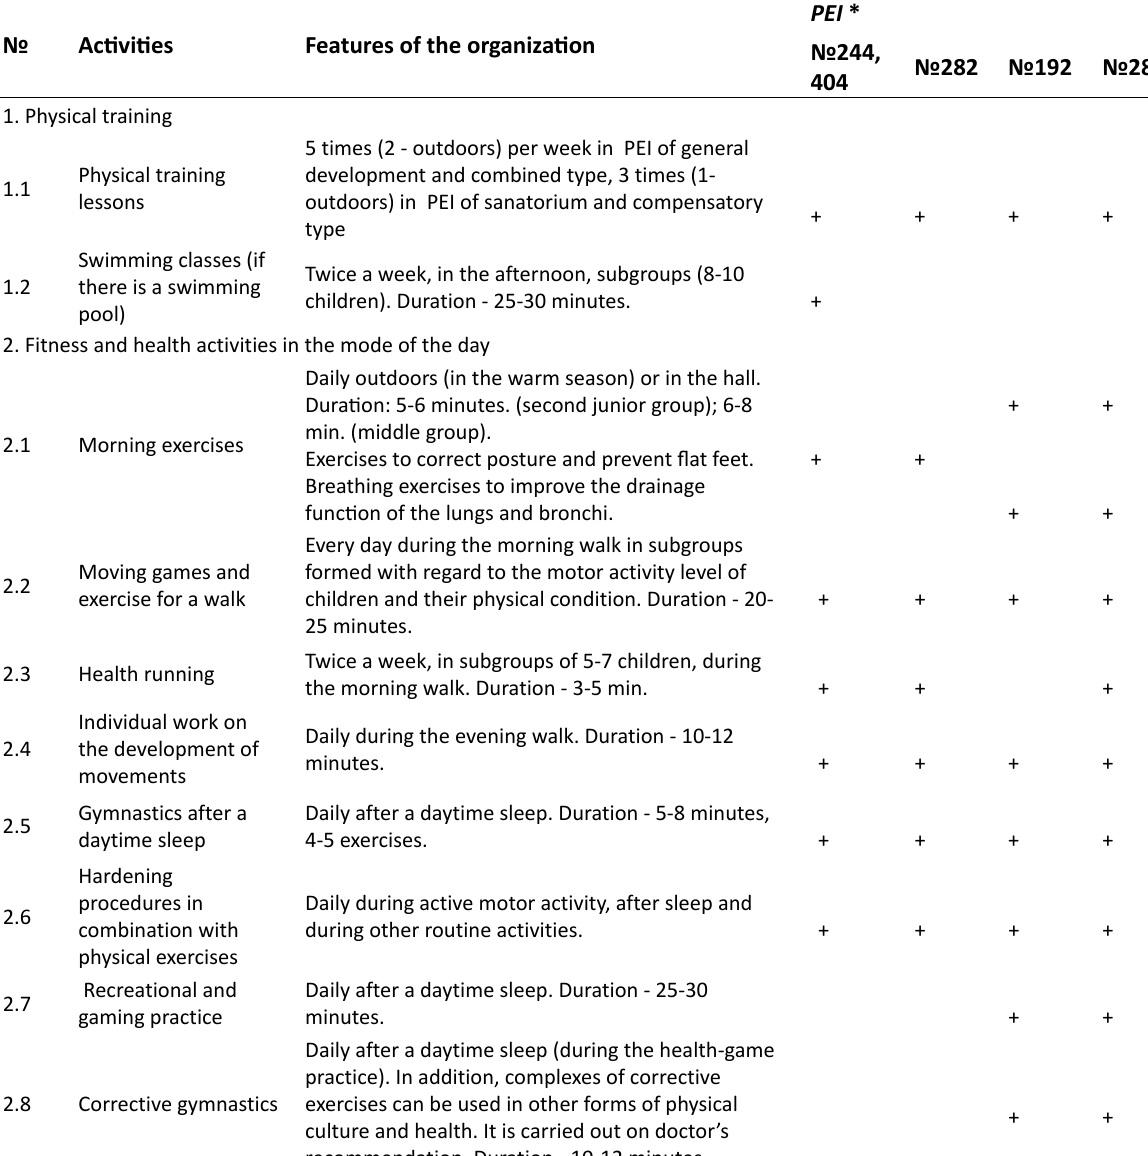
Table 1. Forms of work and types of motor activity of children aged 3-4 years